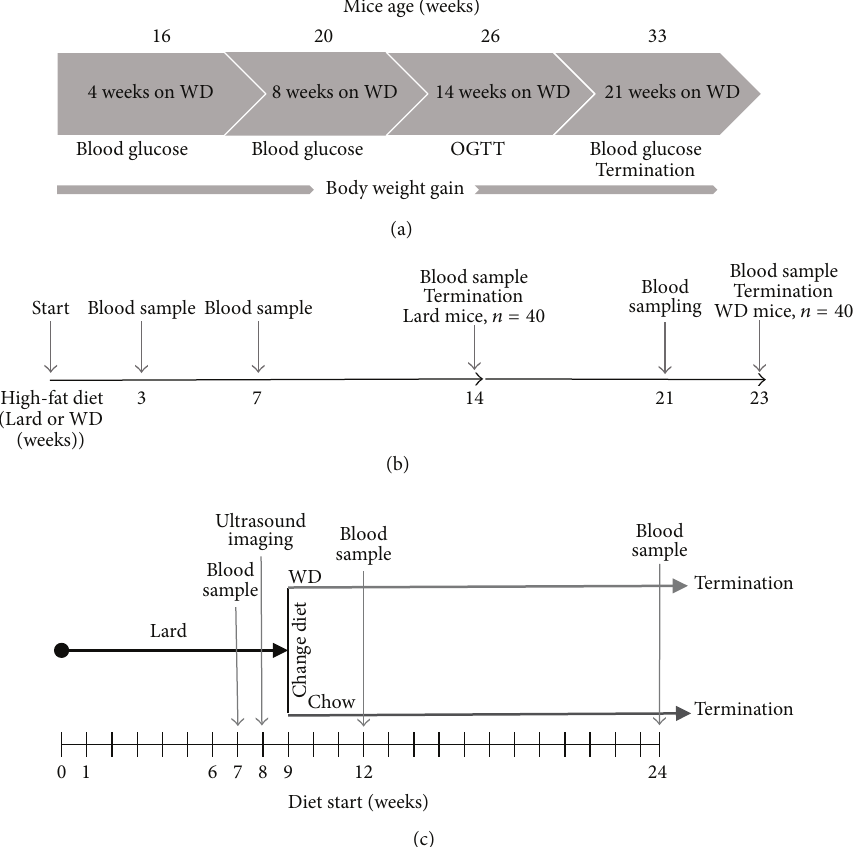
diet (WD) (R638; 21% fat/cocoa butter, 0.15%